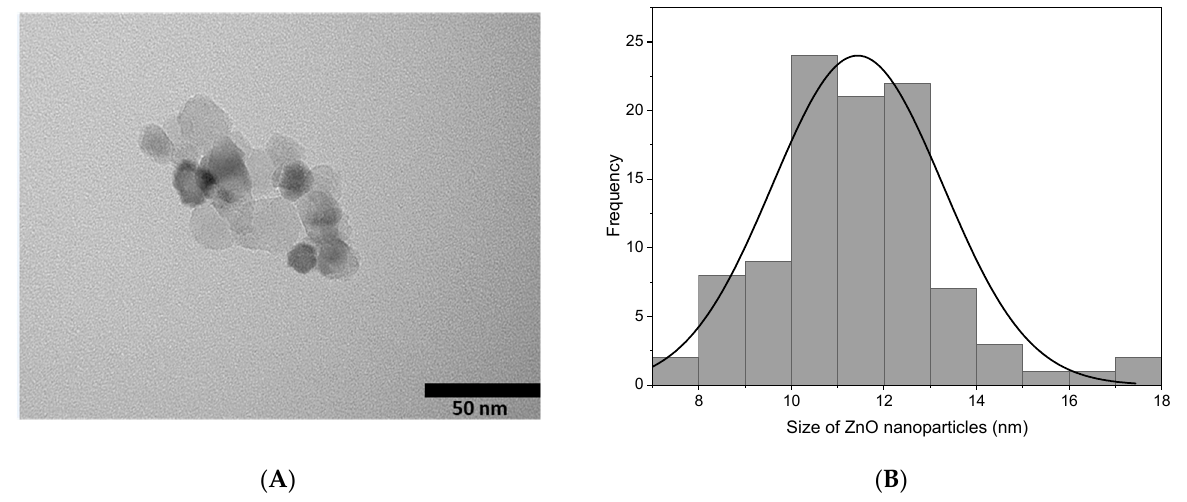
Figure 4. ( A ) TEM images of the ZnO-NPs at 50 nm and ( B ) histogram of the ZnO-NPs.